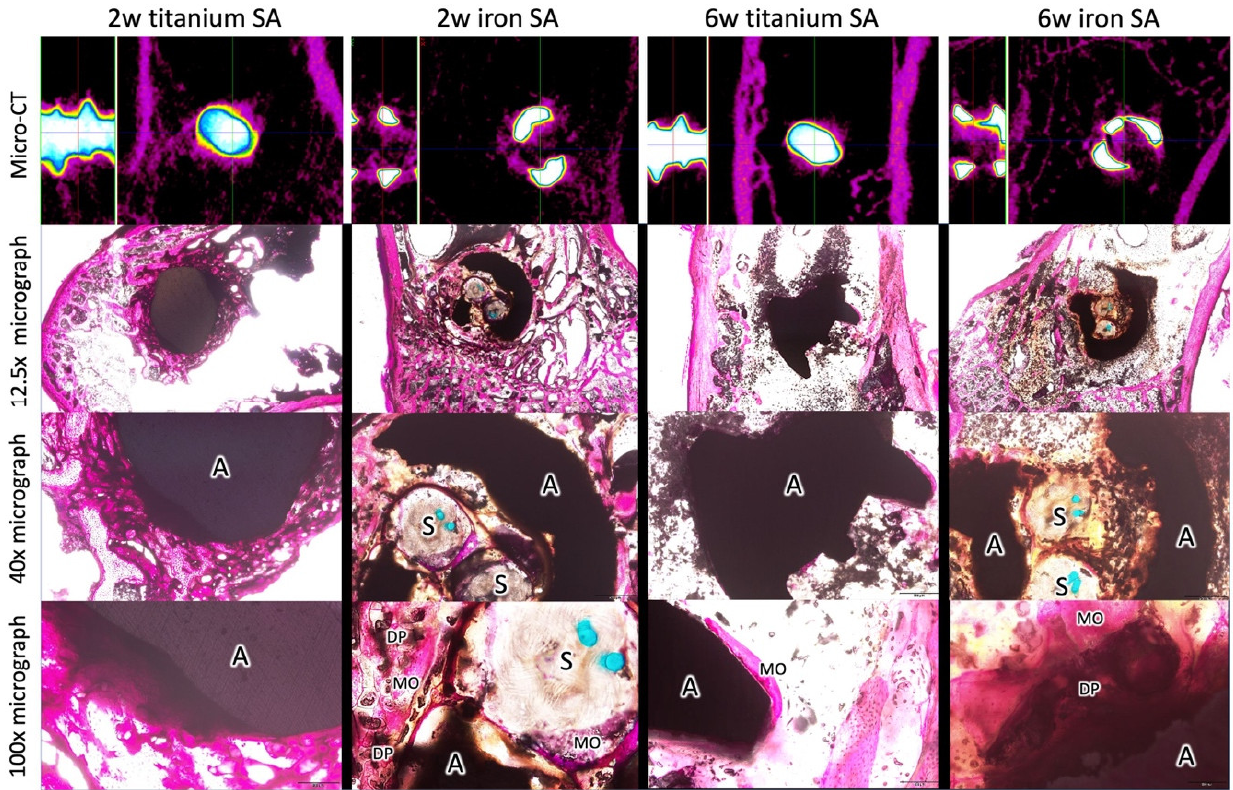
Figure 15. Micro-CT and histological examination of the bone–SA interface 2 and 6 weeks postoperation. w, week; A, anchor; S, suture; DP, degradation products; MO, mineralized osteocytes.